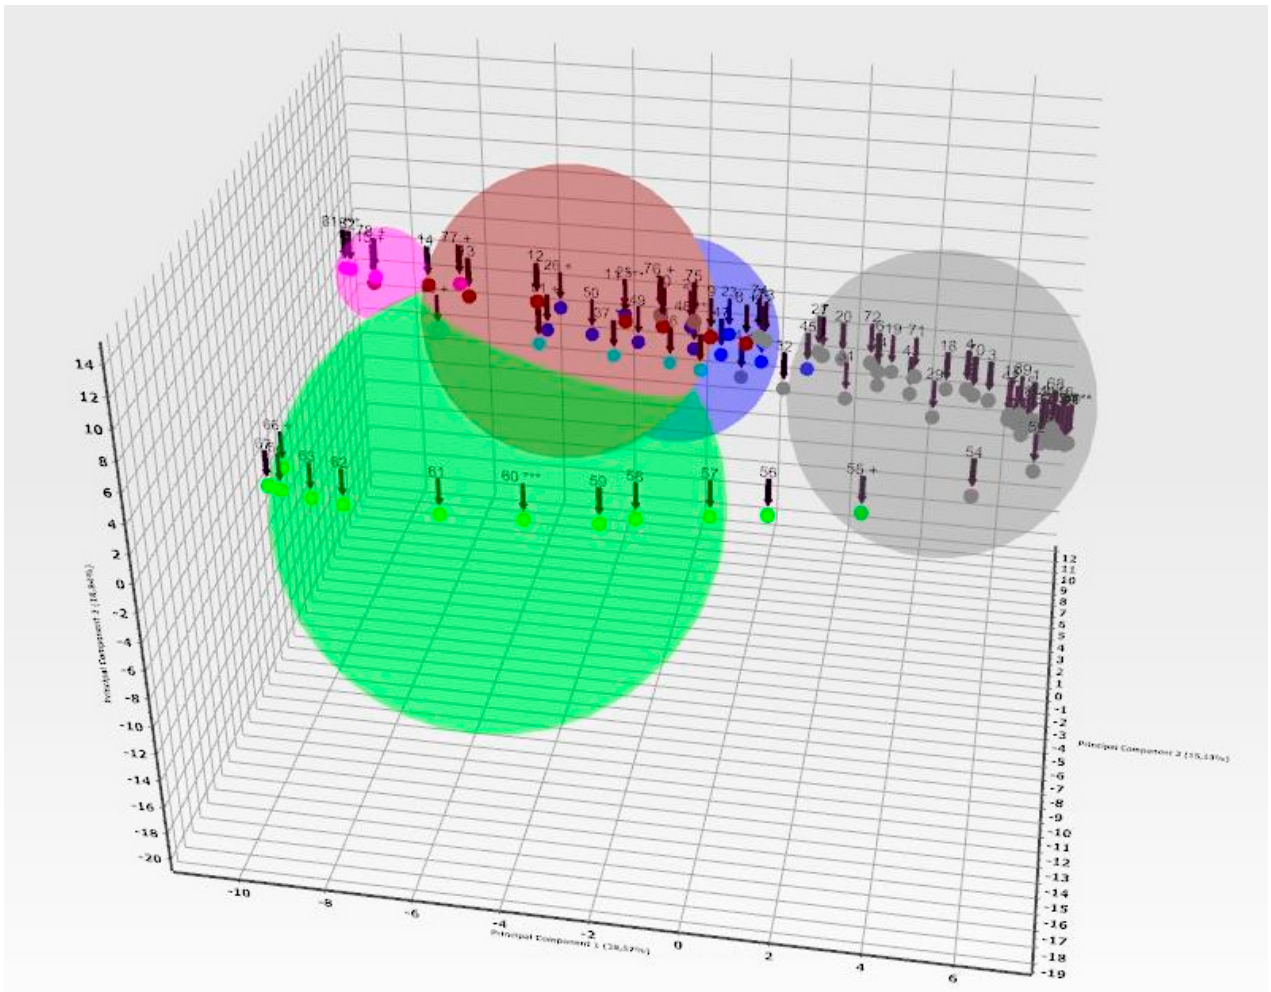
Figure 29. Five Clusters of different lithium mineral ores from different parts of the world with the main minerals separated into different clusters. *** most representative XRD, + most different XRD’s in the cluster